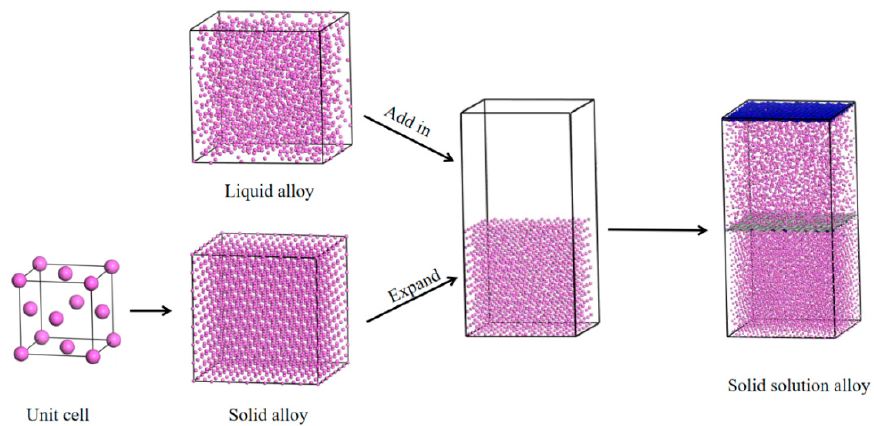
Figure 3. The solid solution model of the Al-Zn-Mg-Cu alloy construction